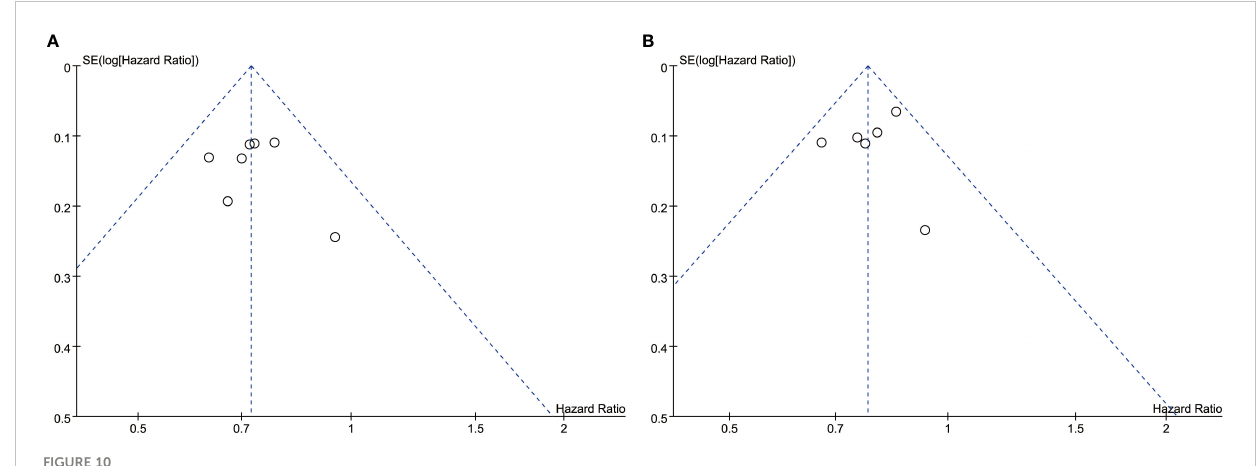
FIGURE 10 (A) Funnel Plot of Overall Survival. (B) Funnel Plot of Progression-Free